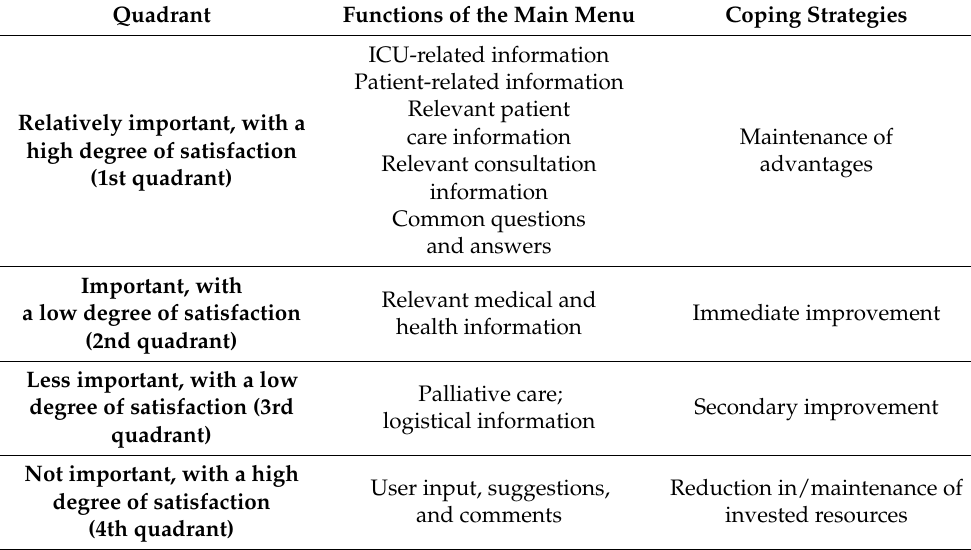
Table 4. Opinions on the functions and related improvement strategies.